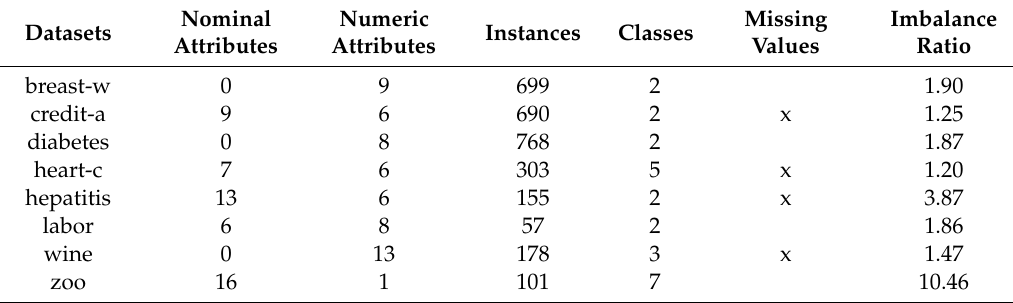
Table 10. Description of repository